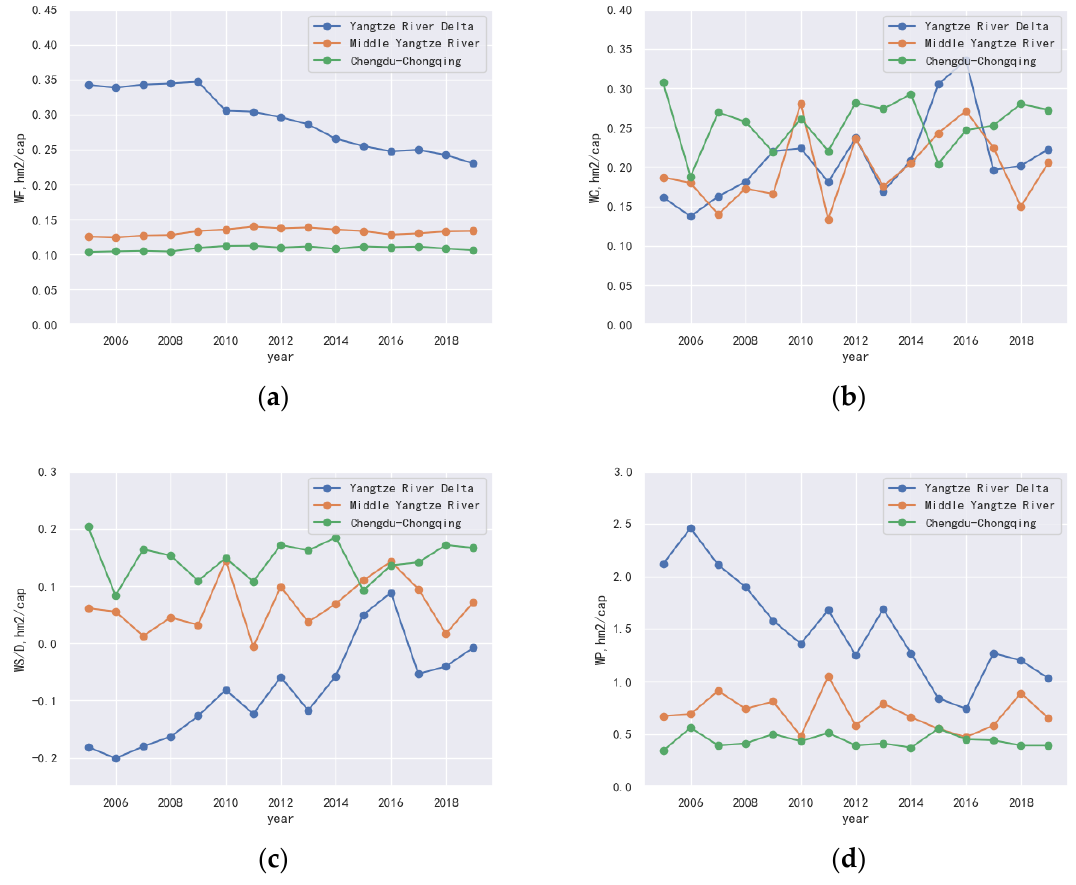
Figure 1. Trends of changes in WEF-related indicators in three urban agglomerations: ( a ) water ecological footprint; ( b ) water ecological capacity; ( c ) water ecological surplus/deficit; and ( d ) water resources ecological pressure index.